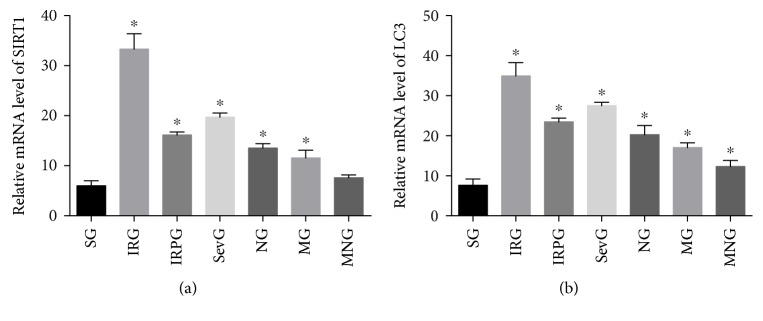
Real-time analysis for mRNA levels of SIRT1 and LC3 in different groups. (a) Relative mRNA levels of SIRT1. (b) Relative mRNA levels of LC3. All data were represented as mean values ± S.D. ∗P < 0.05 via SG, n = 7.